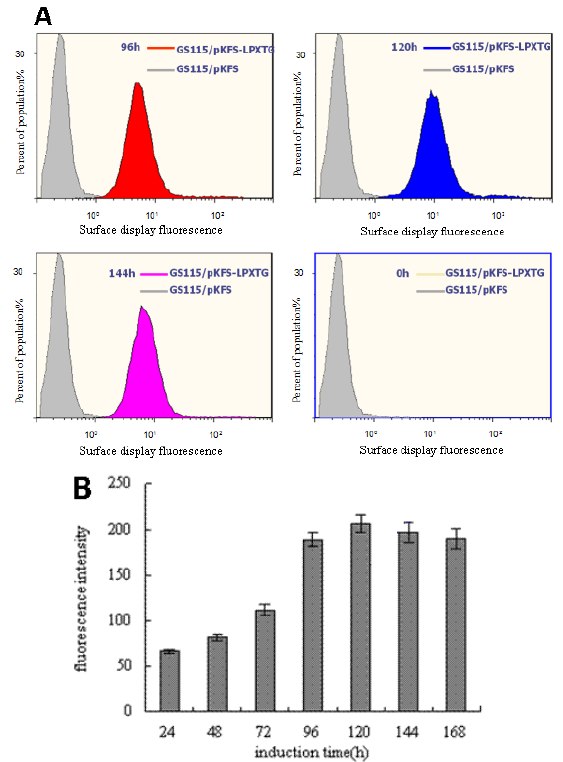
Figure 3. Detection of LPXTG-EGFP displayed on yeast surface. ( A ) Flow cytometry detection of LPXTG-EGFP displayed on yeast surface. ( B ) Fluorescence spectrophotometry detection of LPXTG-EGFP displayed on yeast surface. LPXTG-EGFP displayed on yeast